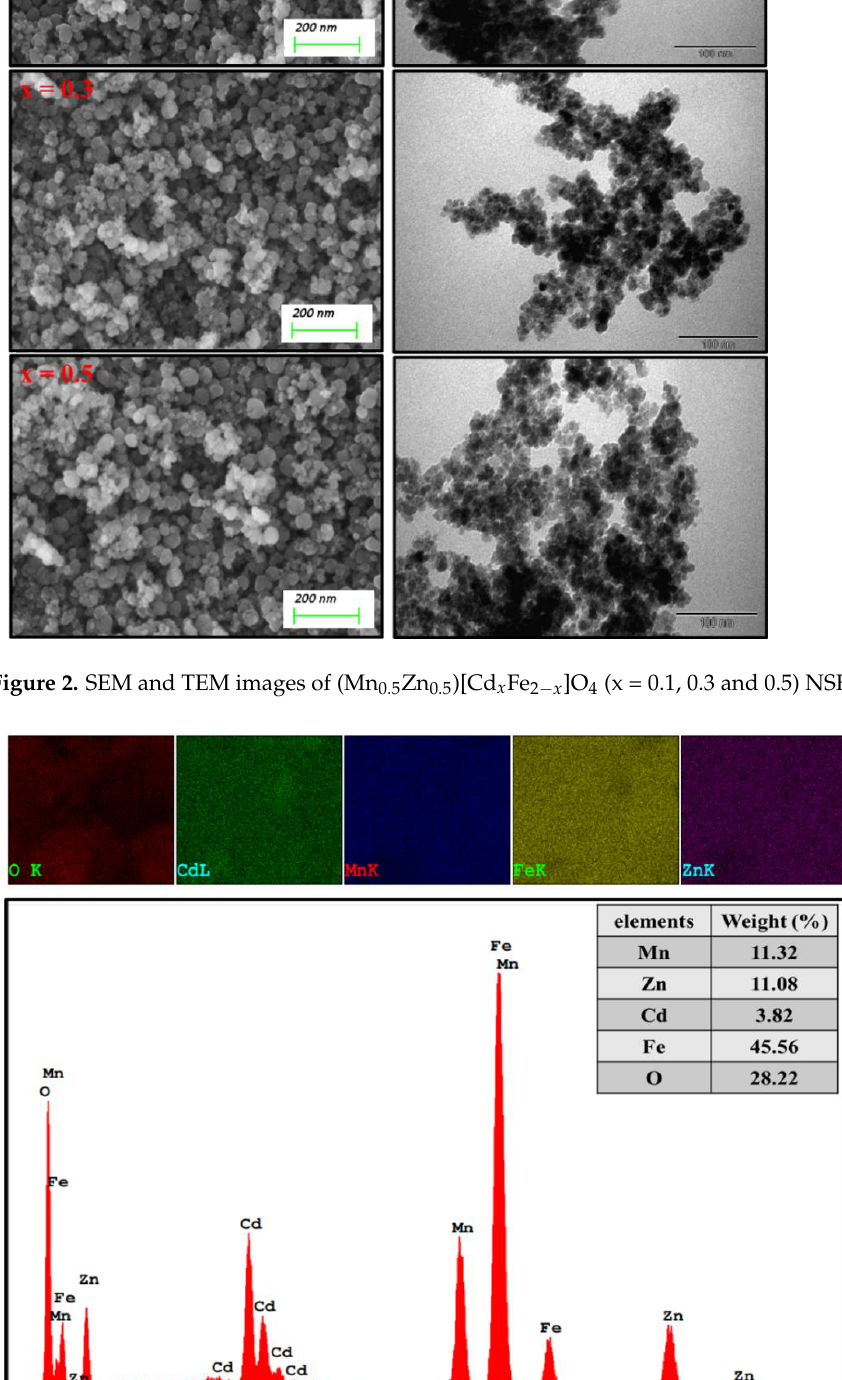
Figure 3. EDX and elemental mapping of (Mn 0.5 Zn 0.5 )[Cd x Fe 2− x ]O 4 (x = 0.2) NSFs.